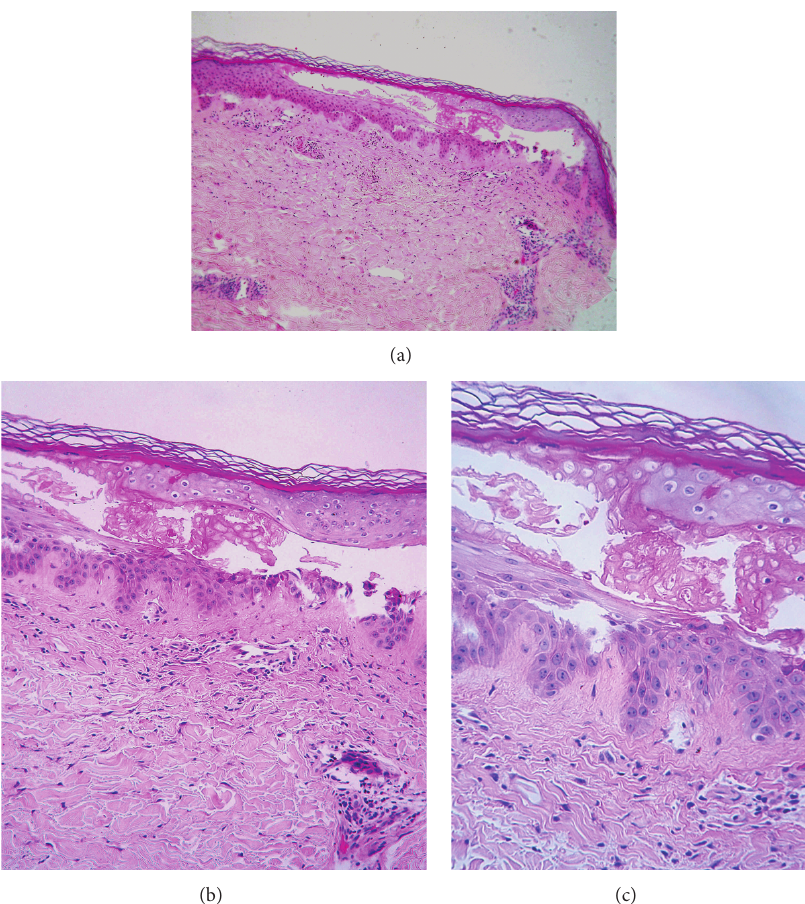
Figure 2: (a) H&E section, × 100 magnification showing an acute totally intraepidermal blister. At both angles of the blister, the separation is entirely intraepidermal. Stratum corneum is intact which attests the acute onset of the lesion, and no signs of regeneration can be seen. No evidence of common pathological changes that induce intraepidermal blister as acantholysis or ballooning degeneration. No inflammatory cells in or around the lesion. (b) H&E section, × 200 magnification showing epidermal separation at the level of the spinous layer. Necrotic individual keratinocytes can be seen intravesicular and at the roof of the blister (no acantholysis, no ballooning or multinuclear cells). (c) H&E section, × 400 magnification showed sparse perivascular infiltrate, and collagen bundles in the papillary dermis are separated by scanty mucin